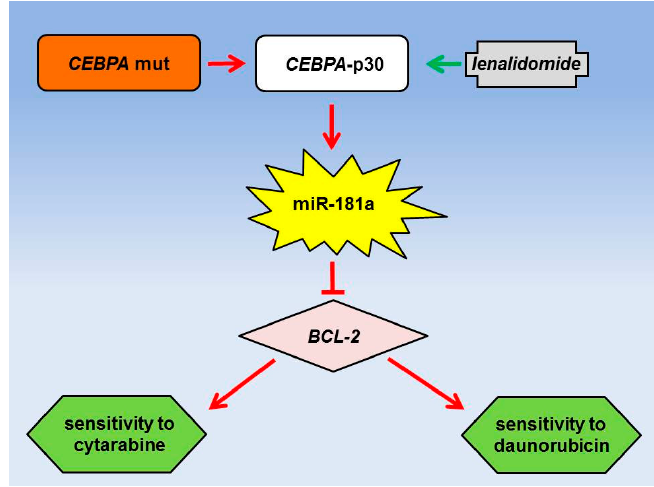
Figure 1. Example of a miRNA network influencing therapeutic sensitivity in acute myeloid leukemia (AML) high-intensity treatment. N-terminal mutations in CEBPA enable translation of a truncated CEBPA -p30 isoform, which in turn induces miR-181a [58]. As a consequence, BCL-2 —a direct miR-181a target—is downregulated, which in turn increases the sensitivity to both cytarabine and daunorubicin [49,50,58]. Interestingly, expression of CEBPA -p30 is induced by lenalidomide as well [58].